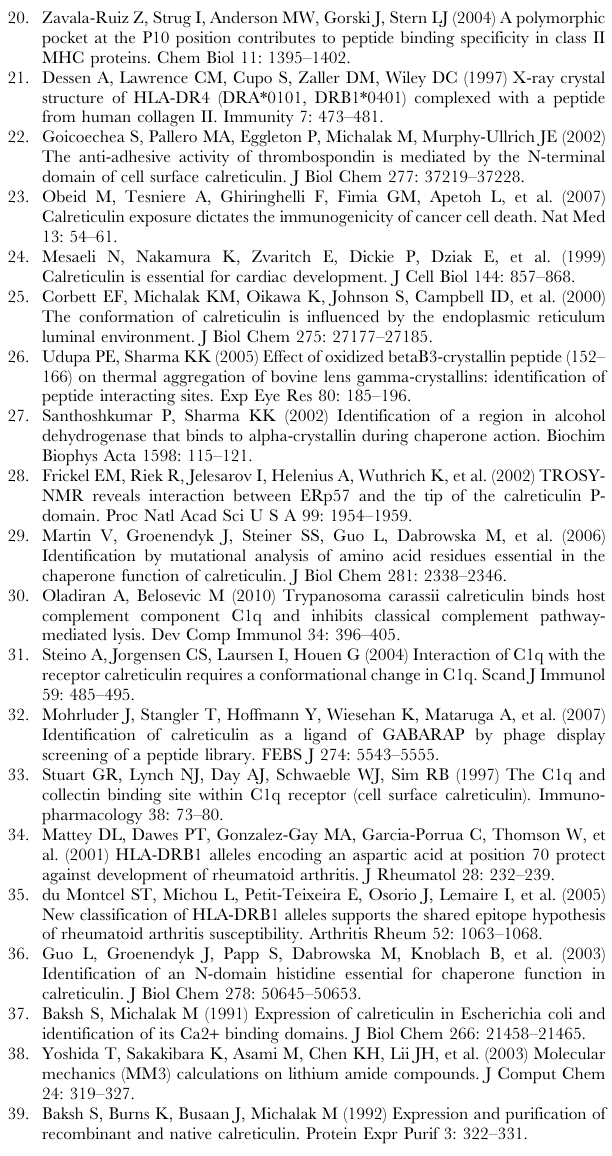
Table S1 Primers for rabbit and mouse CRT site-directed